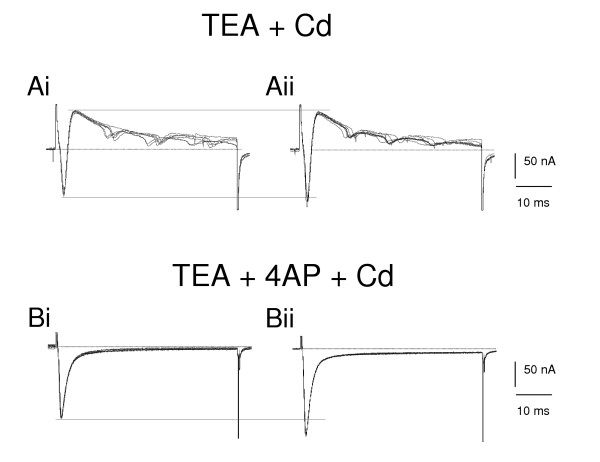
Octopamine selectively enhances the pharmacologically separated fast inward current on B4 neuron. Ai. In the saline containing 50 mM tetraethylammonium (TEA) and 50 μM cadmium, the maintained outward current is reduced and the trace is dominated by a fast inward and transient outward current during five replicate depolarising voltage steps from -80 to -10 mV. (The small inward currents are caused by incomplete voltage clamp because of the high spontaneous activity of electrically coupled B4 cluster neurons). Aii. After 10 μM octopamine is added to this saline the fast inward component is increased without changing the outward component. Bi. In medium containing 50 mM TEA, 4 mM 4-aminopyridine (4-AP) and 50 μM cadmium,, and stepping from -50 to -20 mV, the outward components disappear leaving the fast inward component current (10 replicates). Bii. After adding 10 μM octopamine to the saline, the fast inward current is increased, and a smaller increase is seen in a sustained inward current.